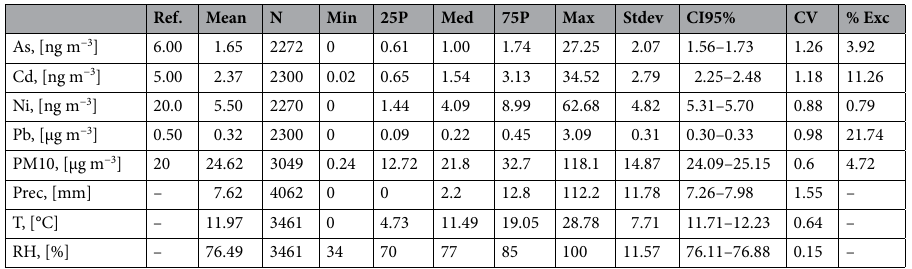
Table 1. Descriptive statistics of daily pollutants data and meteorological parameters in Cop ș a Mică. Ref.